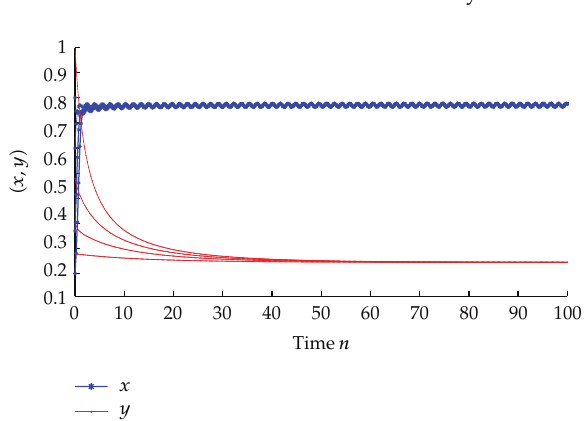
Figure 1: Dynamic behaviors of system (cid:6) 5.1 (cid:7) with the initial values (cid:6) 0 . 14 , 0 . 3 (cid:7) , (cid:6) 1 . 0 , 0 . 24 (cid:7) , (cid:6) 0 . 6 , 0 . 5 (cid:7) , and (cid:6) 0 . 4 , 0 . 8 (cid:7)